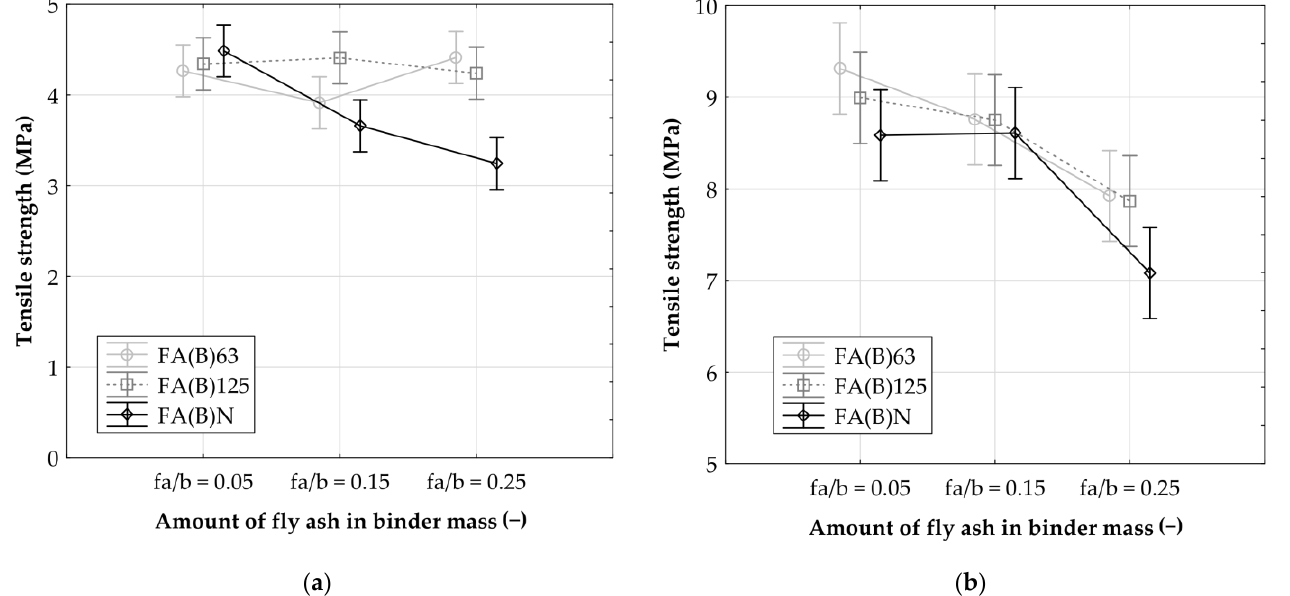
Figure 6. The ( a ) 2-day and ( b ) 90-day tensile strength test results of mortars with the addition of sieved fly ash (FA(B)63 or FA(B)125) compared with the results of mortars with untreated fly ash (FA(B)N) (ANOVA 95% CI in the whiskers)